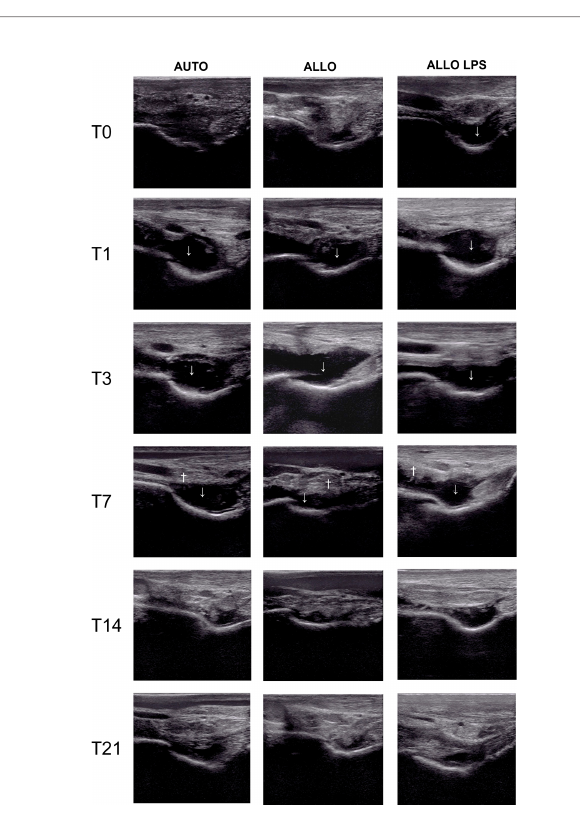
FIGURE 4 | Ultrasonography of tibiotarsal joints before and after the fi rst MSC injection, showing synovial effusion ( ↓ ) and synovial membrane hyperplasia ( † ). Synovial effusion was observed at T0 in ALLO LPS, and at T1 in AUTO and ALLO, and decreased at T14 in all groups. Synovial membrane proliferation occurred at T7 in all groups, although it was more evident in ALLO and ALLO